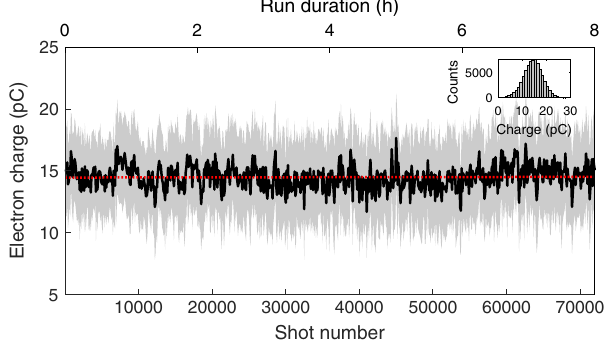
FIG. 2. Measured charge as a function of shot number and run time. The black line shows the 100 shot moving average of the charge with its standard deviation as grey band. A linear fit of all charge measurements is shown in red. Inset: a histogram of the injected